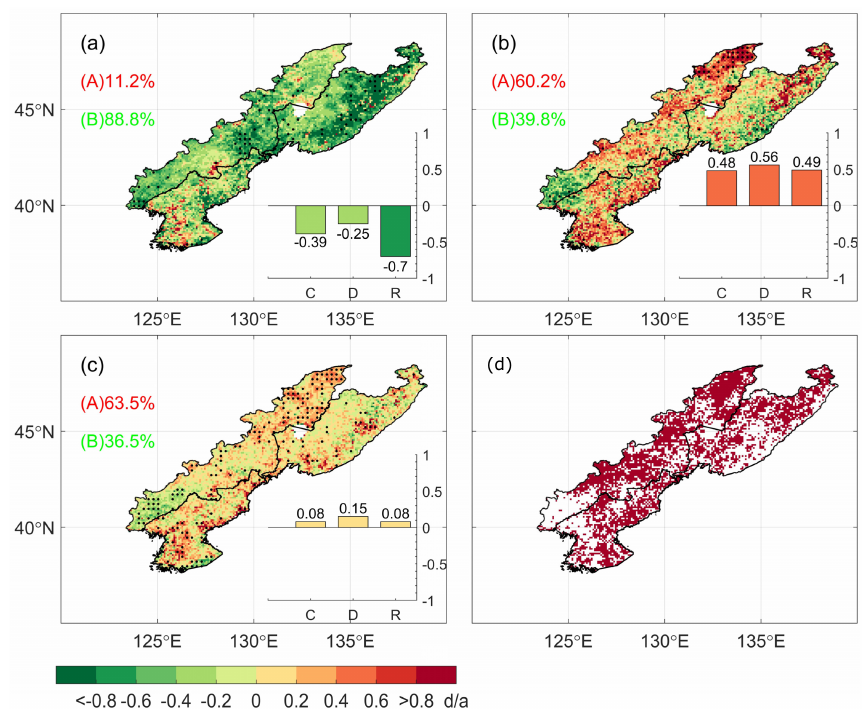
Figure 4. Spatial distribution of trend in SOS in the China–DPRK–Russia cross-border area. ( a ) Trend in SOS from 1982 to 1998. ( b ) Trend in SOS from 1998 to 2015. ( c ) Trend in SOS from 1982 to 2015. ( d ) Spatial distribution of SOS changed from advance trend to delay trend after 1998. The region with dots represents the sites with significant trend ( p <